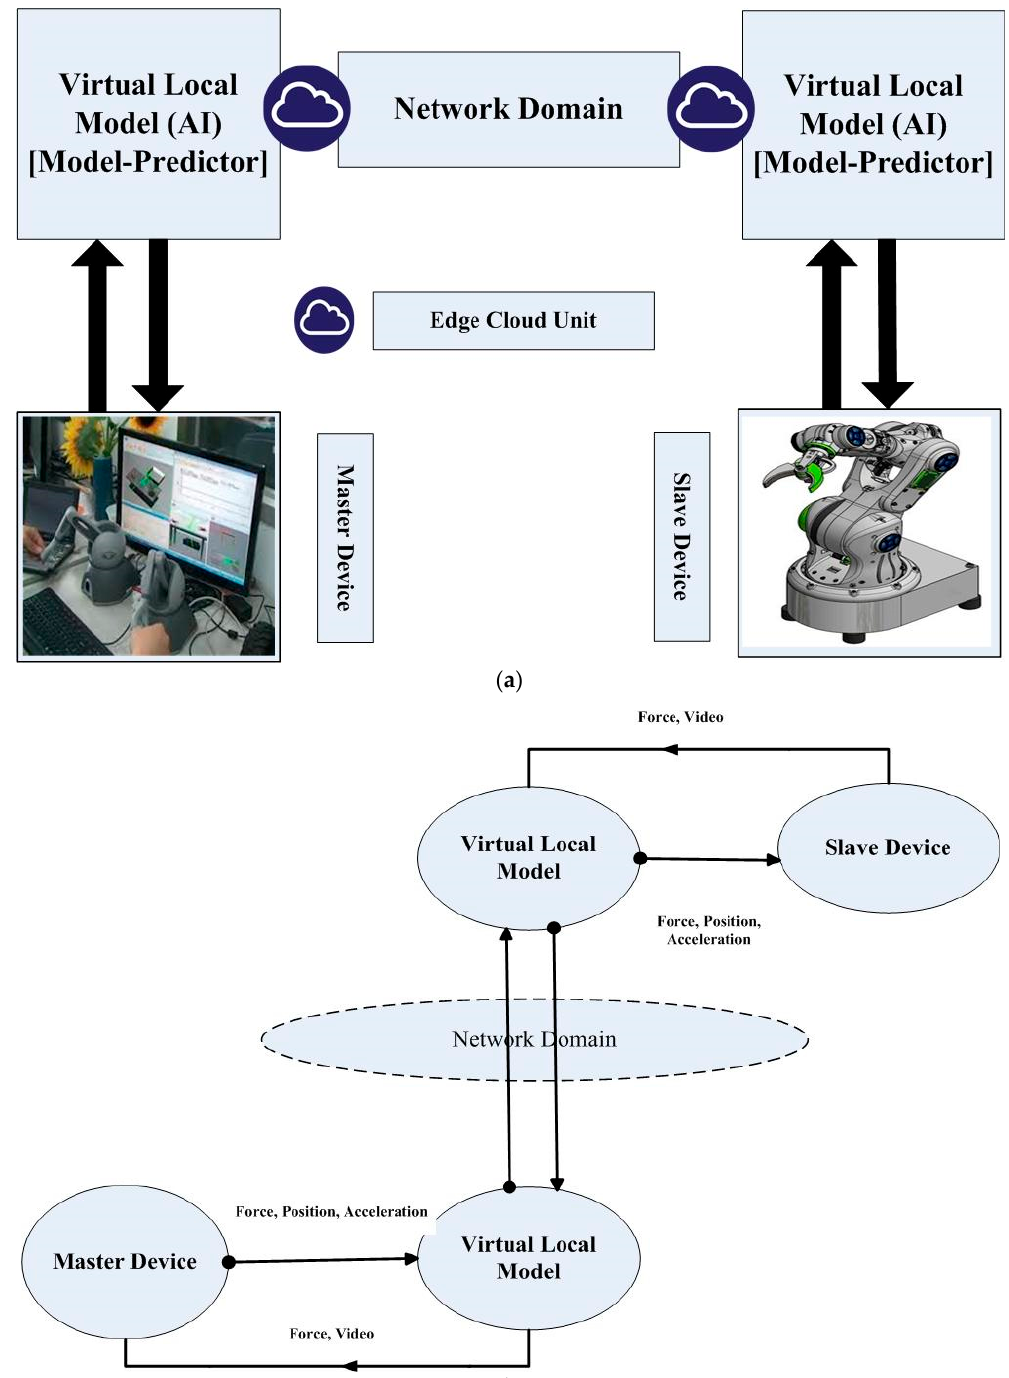
Figure 8. ( a ) End-to-end general structure for the tactile Internet with the AI model mediated. ( b ) Signaling diagram for the tactile Internet system.